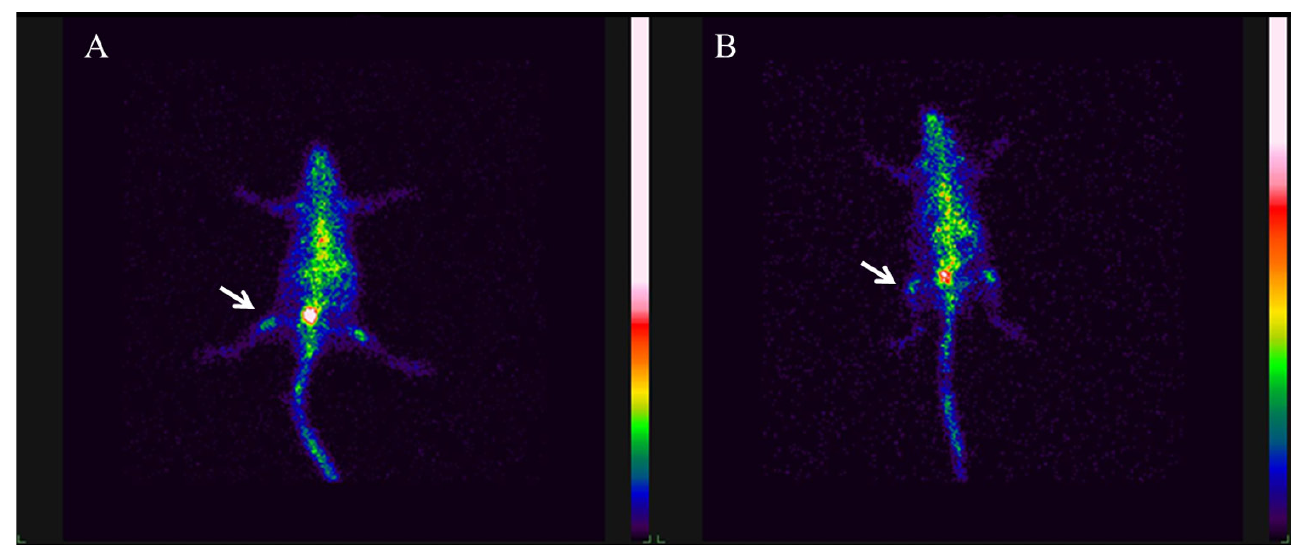
FIGURE 6 - Scintigraphic images obtained at 1 (a) and 4 (b) h after intravenous injection of 99m Tc-CDV into healthy mice (n=7). The arrows indicate bone